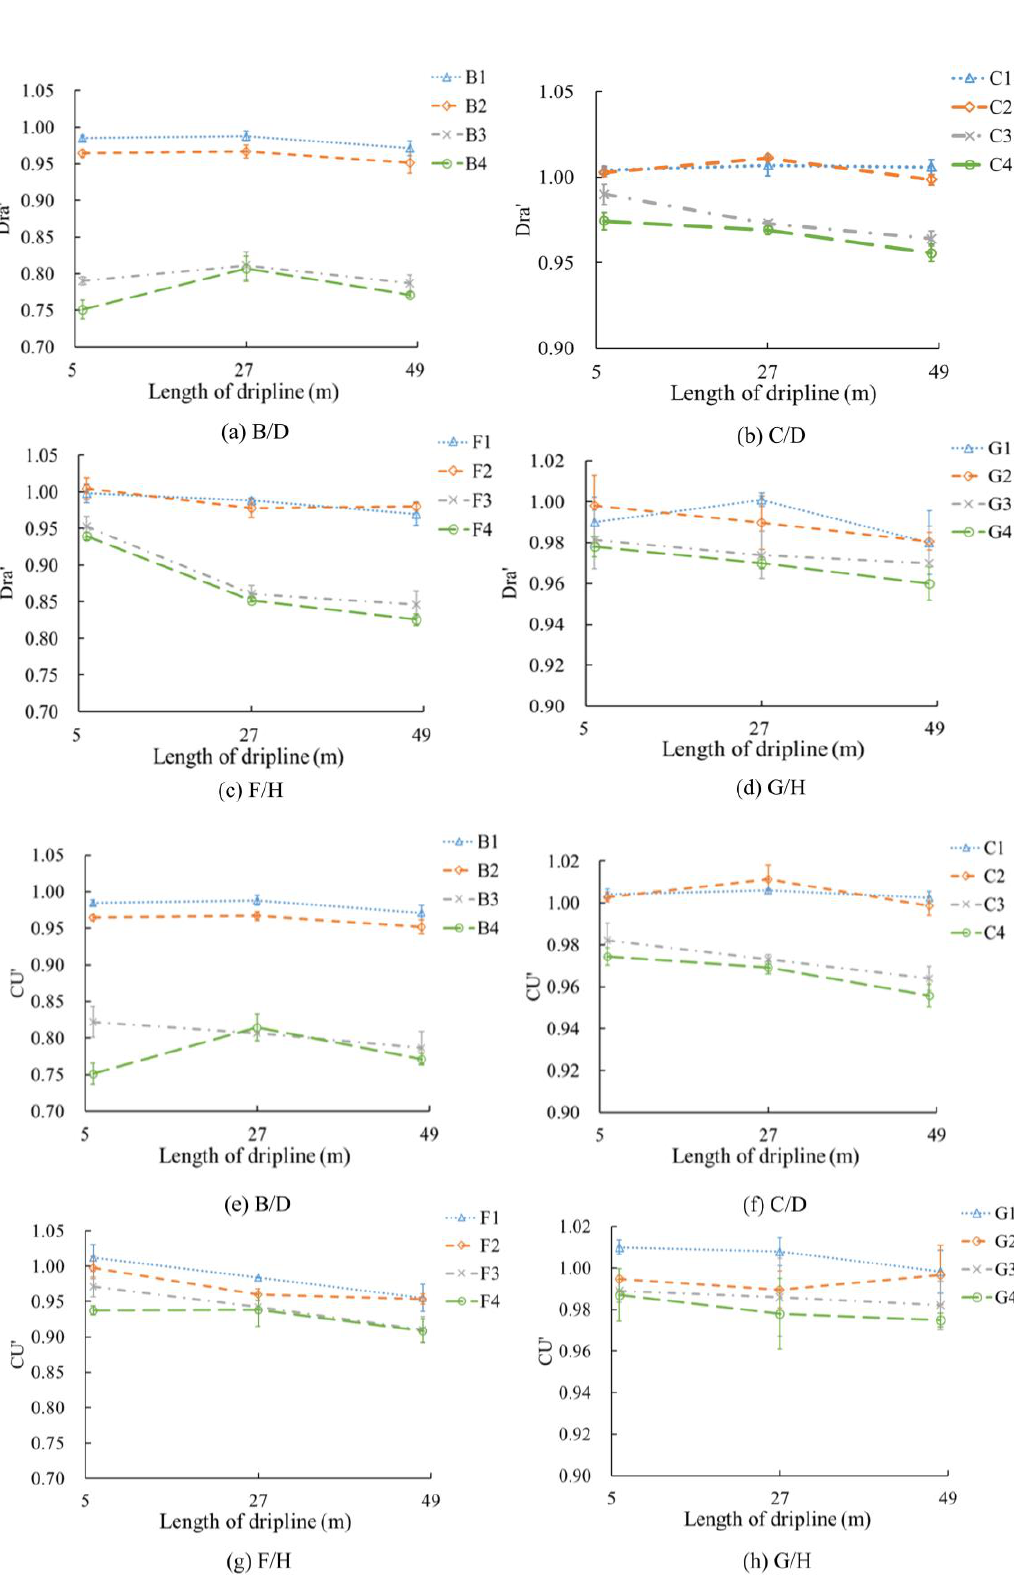
Figure 6. Ratio of Dra and CU between low-pressure conditions and rated pressure. Note: Dra is the average relative discharge; Dra’ is the relative value of Dra (the ratio of Dra in plot B and C to plot D; the ratio of Dra in plot F and G to plot H); CU is the Christiansen uniformity coefficient; CU’ is the relative value of CU (the ratio of CU in plot B and C to plot D; the ratio of CU in plot F and G to plot H); the values are the means ± standard error. B, C, D, F, G and H represent different experi- mental plots. The 1, 2, 3, and 4 after the same letter represent the working conditions of the same